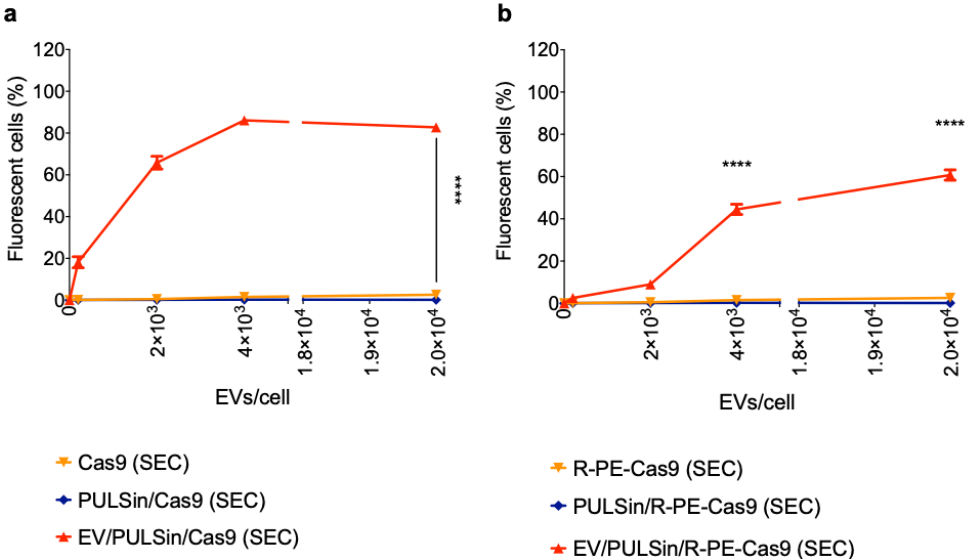
Figure 2. Uptake of Cas9 and Cas9-R-phycoerythrin (R-PE)-loaded EVs in Raw 264.7 macrophage cells. MDA-MB-231 human breast cancer cell-derived EVs were loaded with PULSin/Cas9 (Cas9 was labeled with Alexa Fluor 488) or PULSin/Cas9-R-PE. SEC was used to remove free protein, PULSin and PULSin/protein. The Cas9 or Cas9-R-PE amount in each sample loaded through SEC was equivalent and cells were treated with an equal volume of the elution fraction 7–9. Cellular uptake was assessed by flow cytometry after a three-hour incubation period. ( a ) Uptake of Cas9-loaded EVs and controls. ( b ) Uptake of R-PE-Cas9-loaded EVs and controls. Data are presented as mean ± SD of three replicates. Statistical analysis was performed by two-way ANOVA with post-hoc pairwise comparisons using Tukey’s test. ****, p < 0.0001 in comparison to PULSin/Cas9 (SEC) or Cas9 (SEC). In figure a, **** pertains to all doses except 0